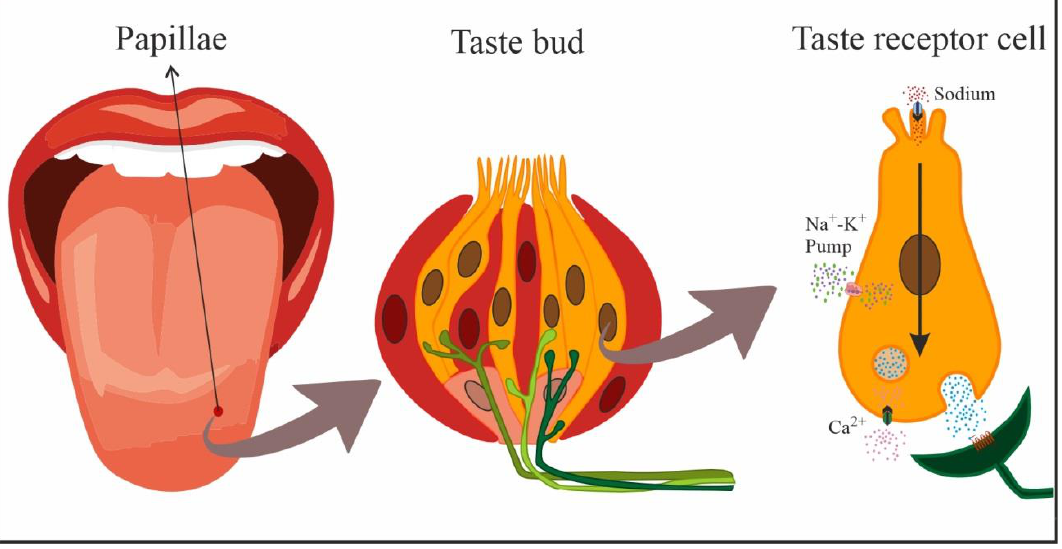
Figure 2. Schematic representation of cells in a taste bud, and transduction of NaCl taste in a taste receptor cell (yellow: taste receptor cells, red: support cells, pink: immature precursor cells). Taste receptor cells form synapses with afferent nerve fibers that penetrate the taste bud, crossing the basal membrane.